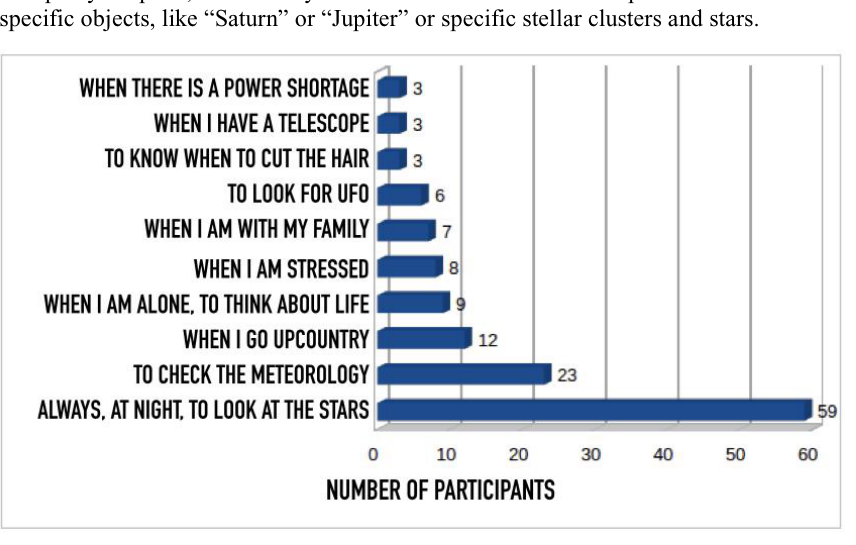
Fig. 2. Answers to the question “do you observe the sky?